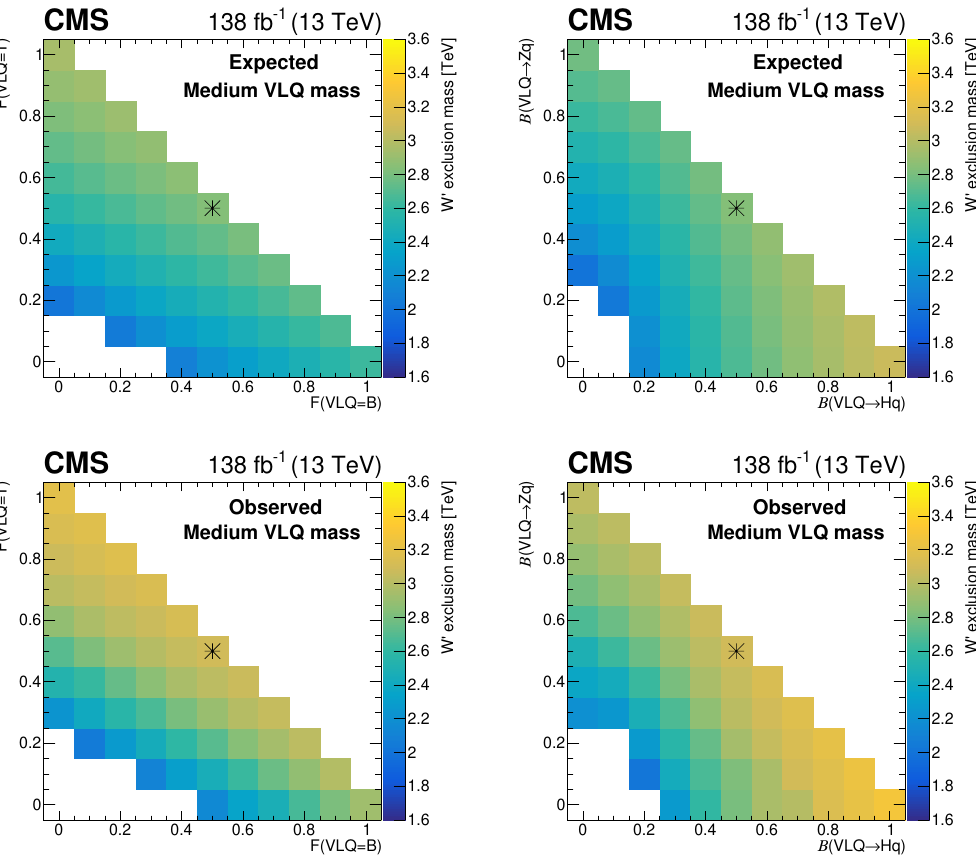
Figure 8 . Expected (upper) and observed (lower) 95% CL limits for generalized hypotheses varying the fraction of tB (F(VLQ= B )) and bT (F(VLQ= T )) from the W 0 decay (left), and the VLQ branching fraction to qH and qZ (right). The asterisk marker signifies the branching fractions for the benchmark